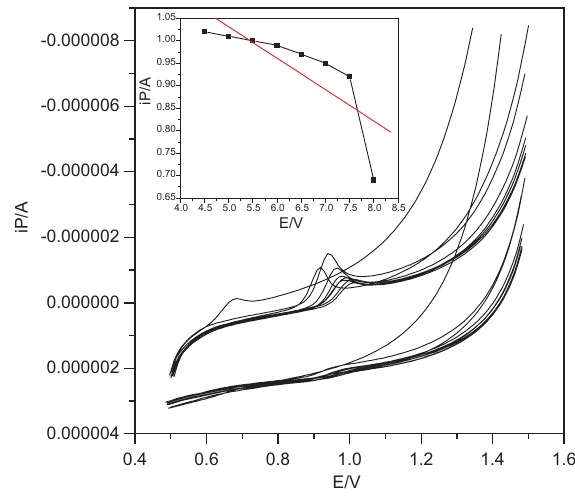
Figure 3 Infl uence of different pH values on the cyclic HPM α FP/ GCE in pH=5.5. Phosphate buffer solution voltammograms and 0.1 m m GU (fi gure insert: only phosphate buffer solution on cyclic voltammograms of bare GCE and HPM α FP/GCE); scan rate: 0.1 V/s.